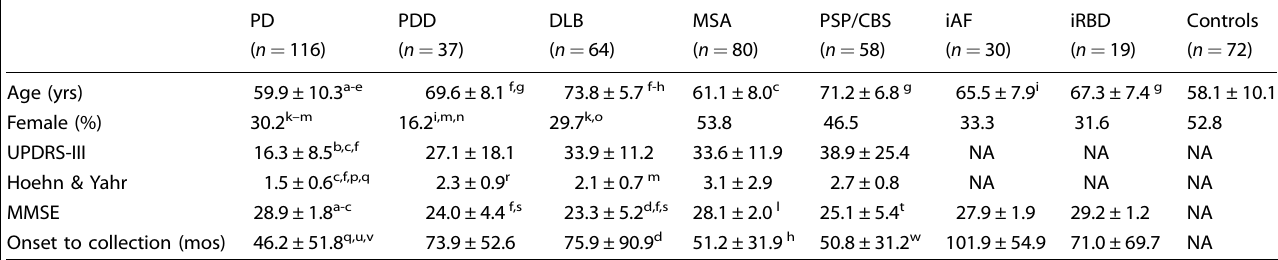
Data are expressed as mean± SD. Depending on data distribution, demographic and clinical features were compared using chi-square and one-way ANOVA (followed by Bonferroni ’ s post-hoc analysis) or Kruskal – Wallis (followed by Dunn ’ s post-hoc analysis) tests: a compared to PDD ≤ 0.0001. b compared to DLB ≤ 0.0001. c compared to PSP/CBS ≤ 0.0001. d compared to iAF ≤ 0.05. e compared to iRBD ≤ 0.05. f compared to MSA ≤ 0.0001. g compared to controls ≤ 0.0001. h compared to iAF ≤ 0.001. I compared to controls ≤ 0.001. k compared to controls ≤ 0.01. l compared to PSP/CBS ≤ 0.05. m compared to MSA ≤ 0.001. n compared to PSP/CBS ≤ 0.01. o compared to MSA ≤ 0.01. p compared to PDD ≤ 0.01. q compared to DLB ≤ 0.01. r compared to MSA ≤ 0.05. s compared to iRBD ≤ 0.0001. t compared to iRBD ≤ 0.01. u compared to PDD ≤ 0.001. v compared to iAF ≤ 0.0001. w compared to iAF ≤